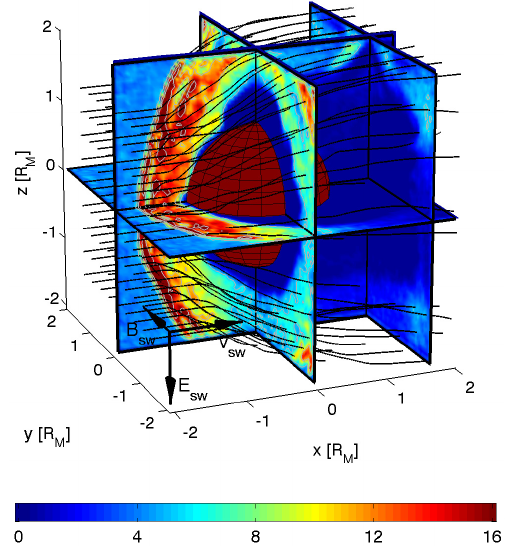
Fig. 4. Simulated solar wind parameters (adaped from B¨oßwetter et al., 2004). The cutting planes show the solar wind density in cm − 3 . The black solid lines represent stream lines of the corre- sponding velocity